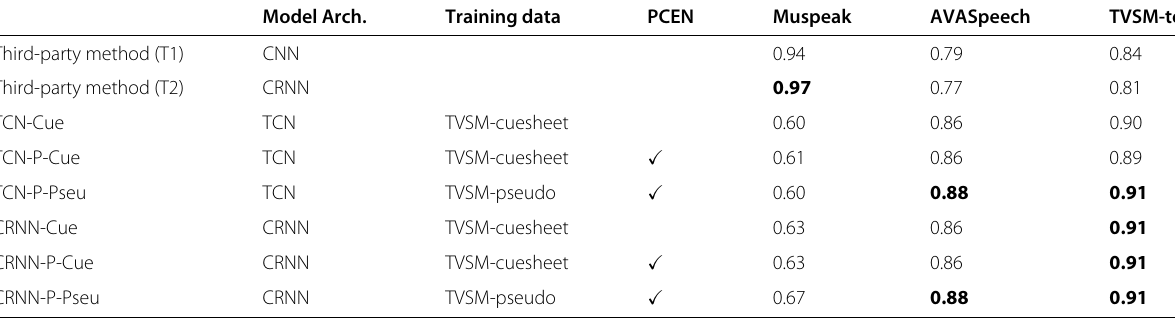
Table 4 F -measures for segment-level evaluation on speech detection Model Arch.